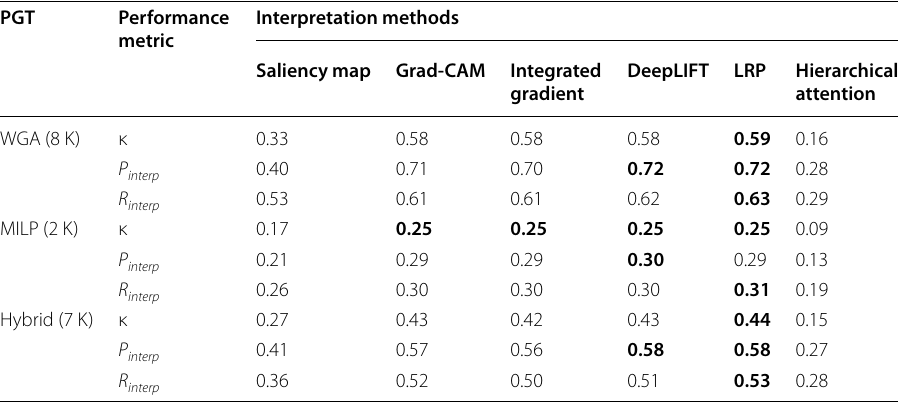
Table 1 The interpretation effectiveness of the interpretation methods using different PGTs on the MR test dataset. The number under each PGT indicates the documents in the training dataset used to generate that PGT. The bold font format indicates the highest